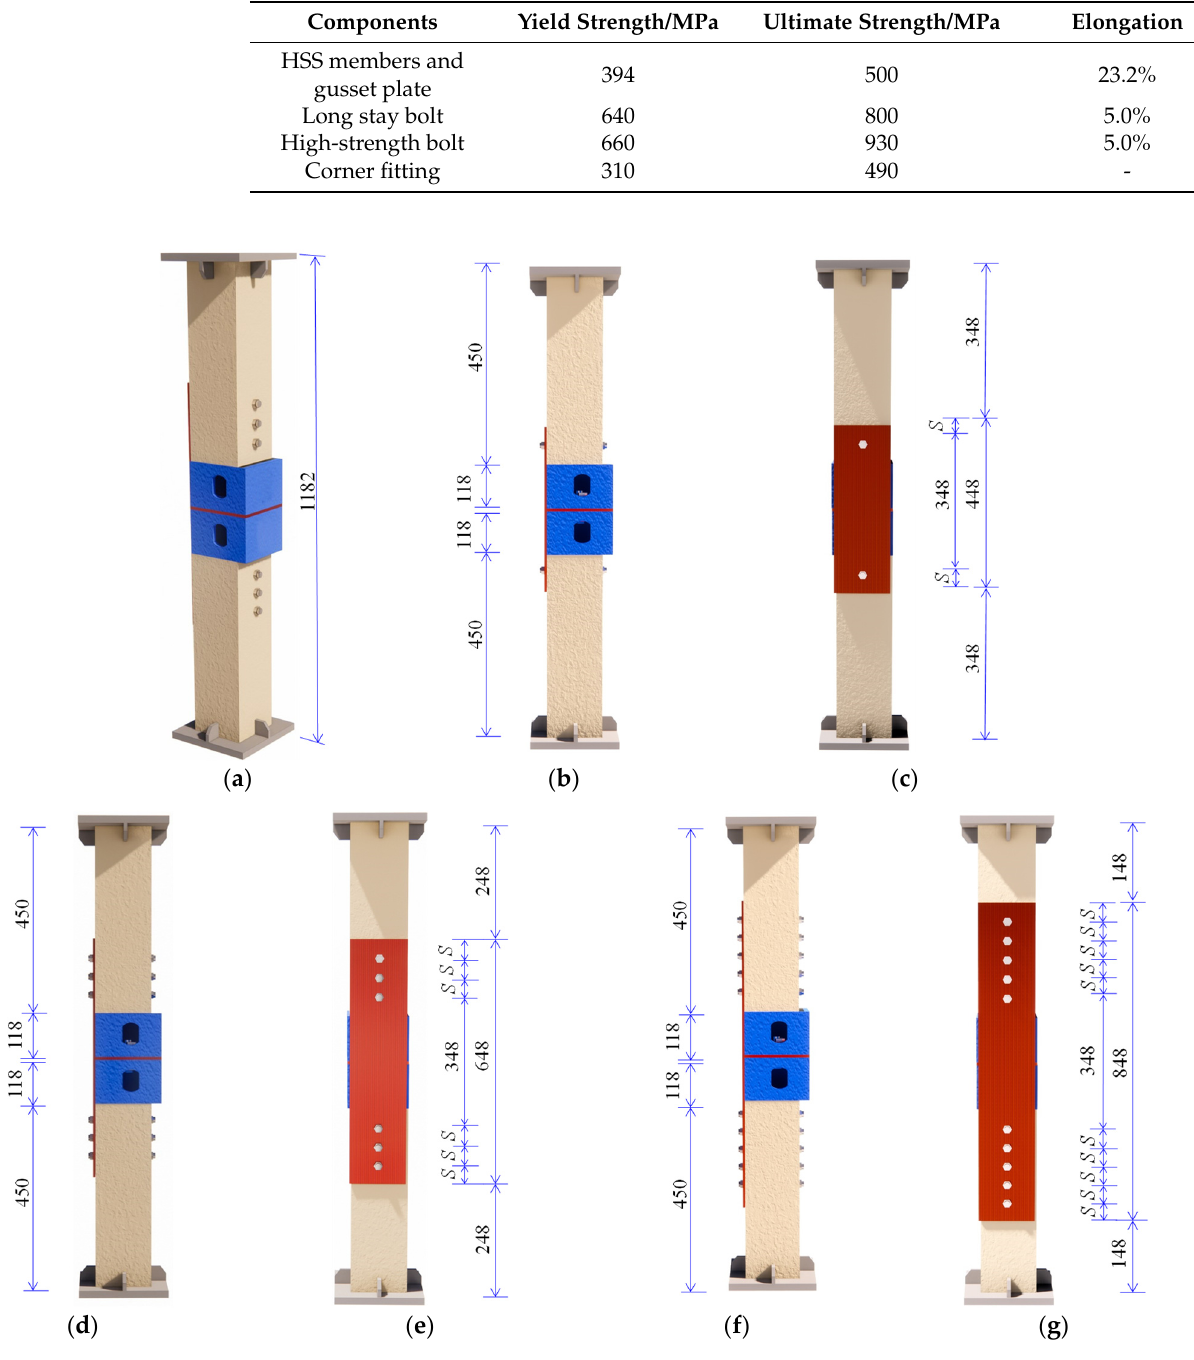
Figure 7. Design of the test specimens (all dimensions in mm): ( a ) 3D view of Specimen SC-2; ( b ) front view of Specimen SC-1; ( c ) side view of Specimen SC-1; ( d ) front view of Specimen SC-2~SC- 4; ( e ) side view of Specimen SC-2~SC-4; ( f ) front view of Specimen SC-5; and ( g ) side view of Spec- imen SC-5. S = 50 mm is the space of the long stay